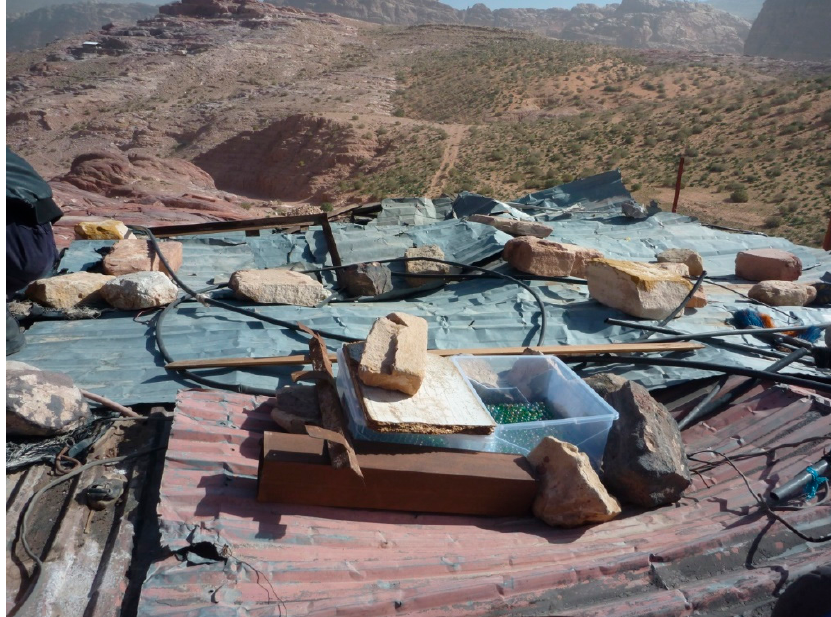
Figure 7. Dust sampler on the roof of Saleh Suleiman's house. Note the ridge of fine sediments in the background to the right, covered by small bushes and patches of grass.